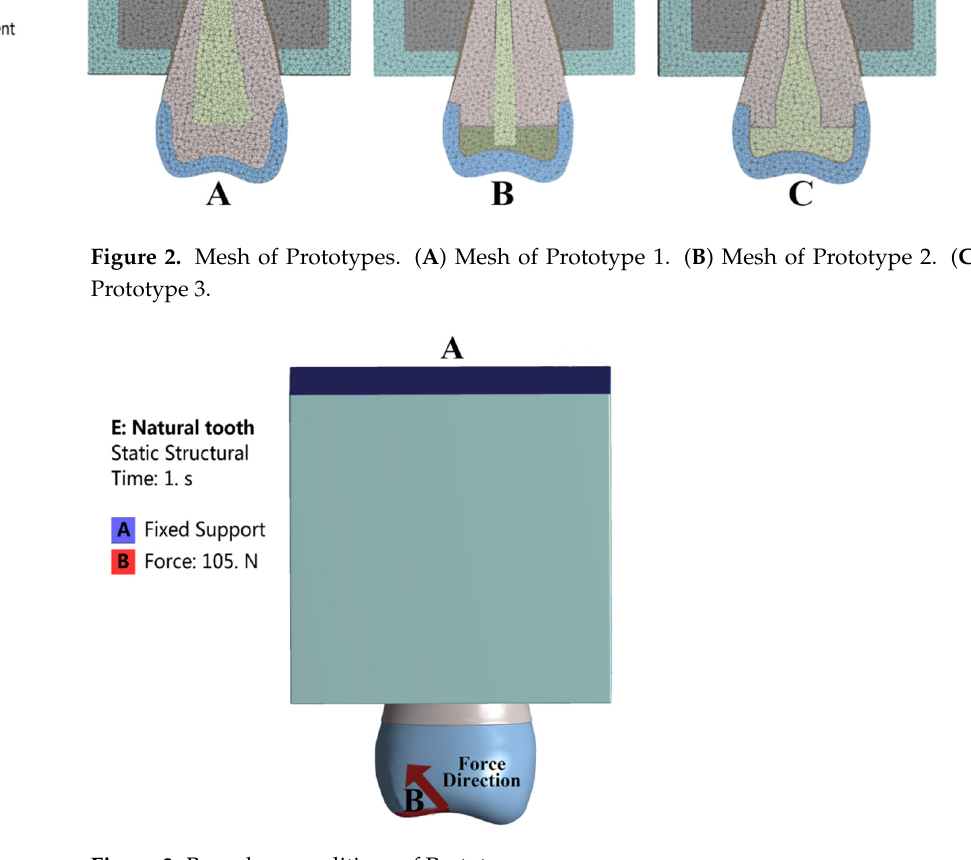
Figure 3. Boundary conditions of Prototypes.